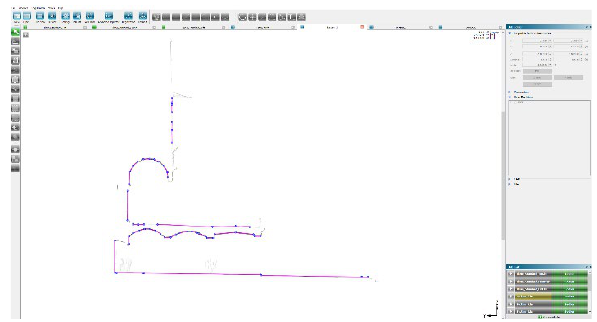
Figure 5: two section visualized in Point-Cab